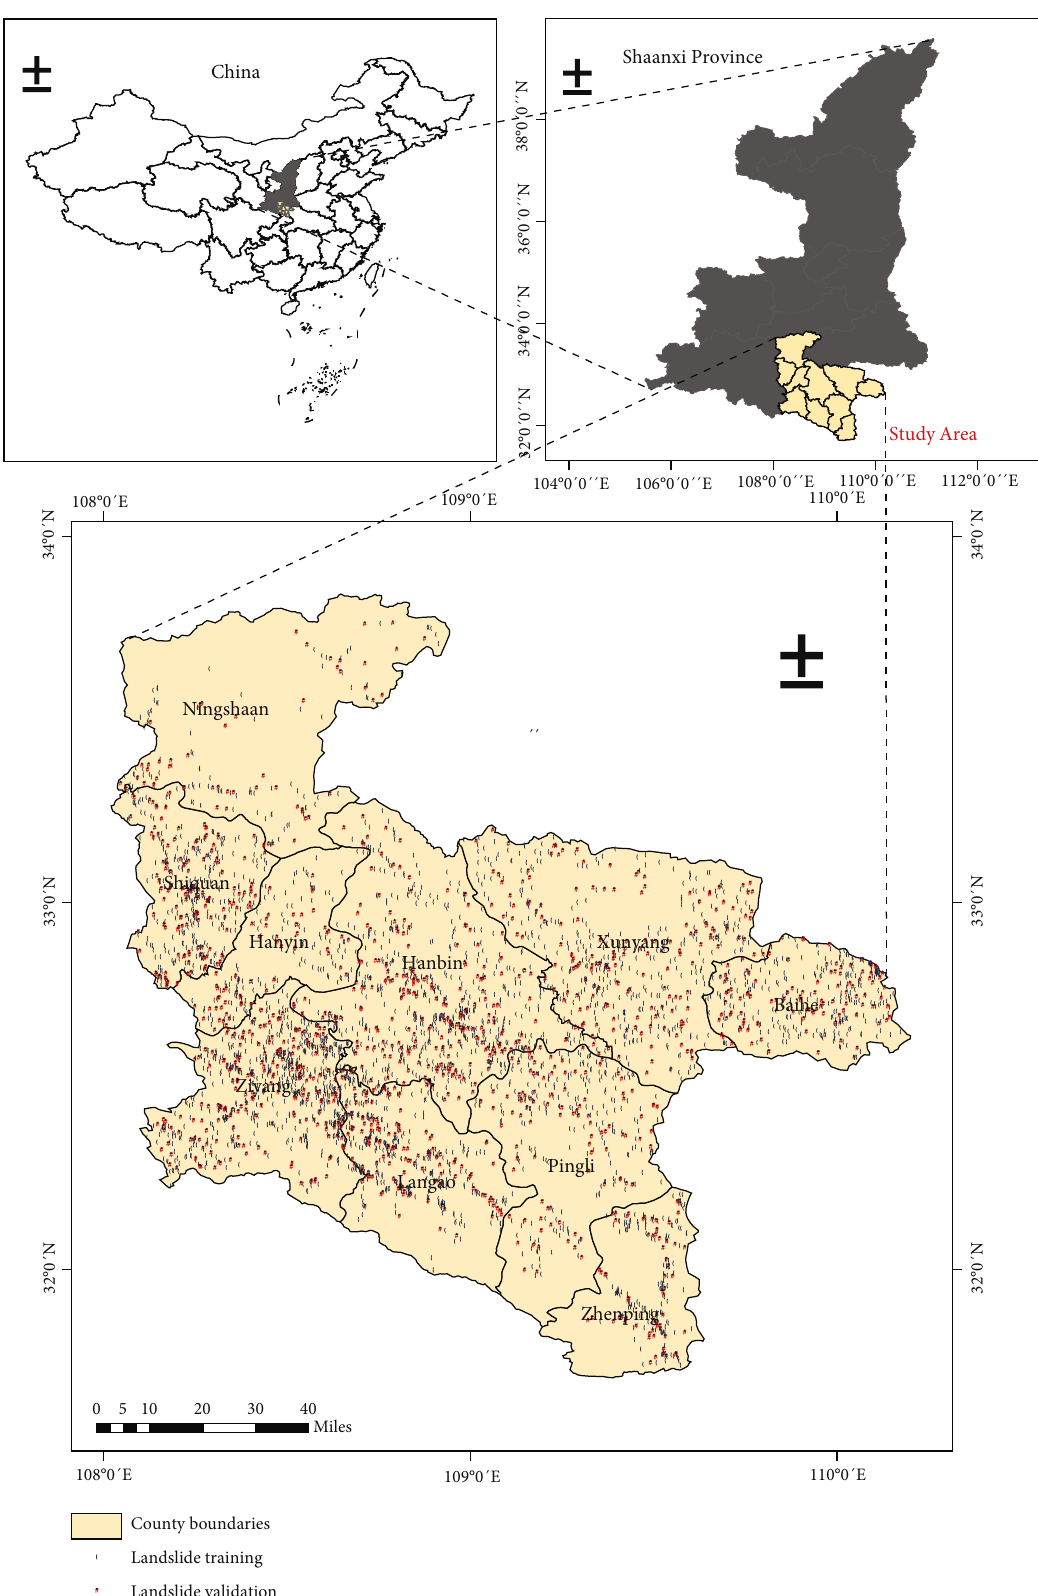
Figure 1: The location of the research area and landslide